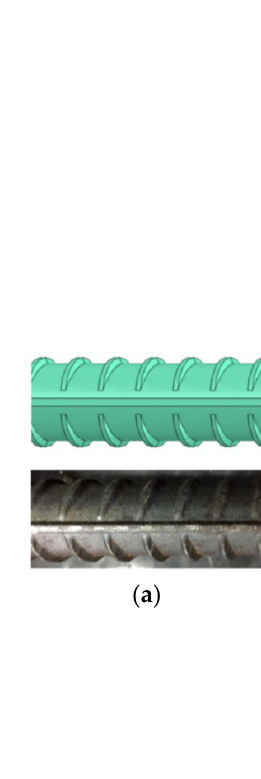
Table 4. The strength values of two kinds of steel bars. d (mm)